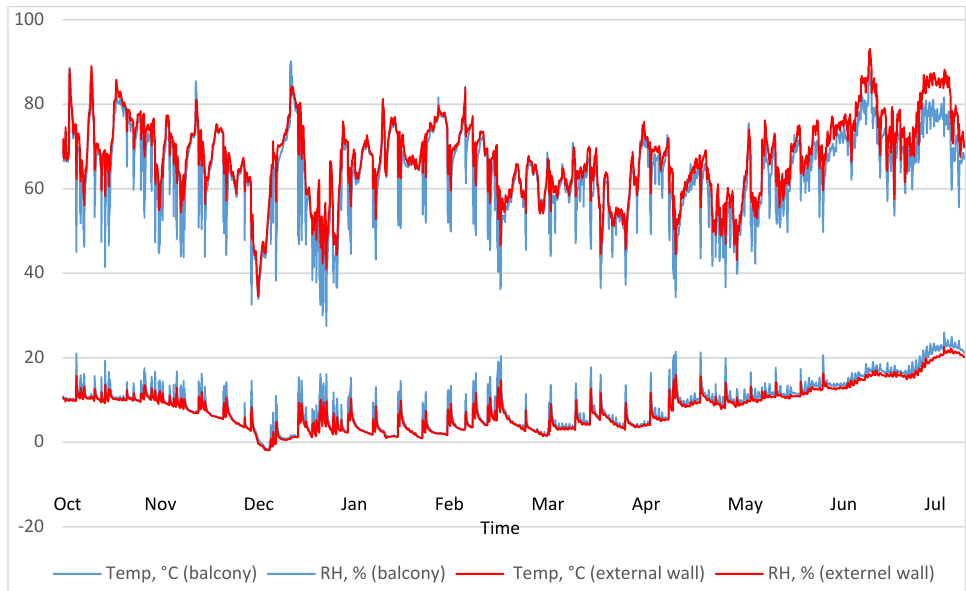
Figure 7. Humidity and temperature measurements in Krimulda church.